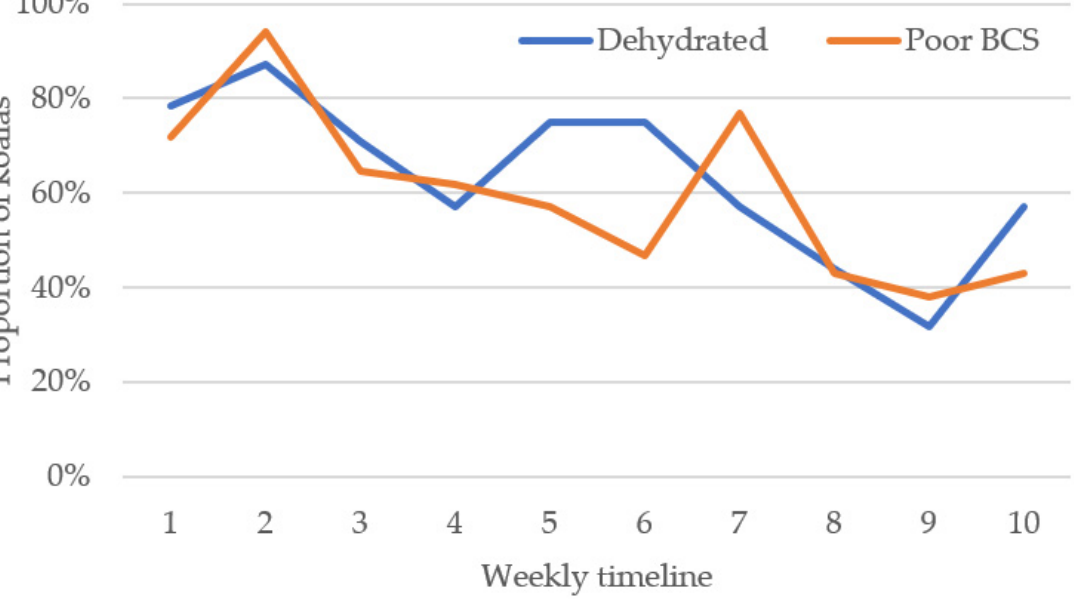
Figure 3. Weekly proportions of koalas clinically assessed with poor body condition (BCS) and dehydration at the time of triage.